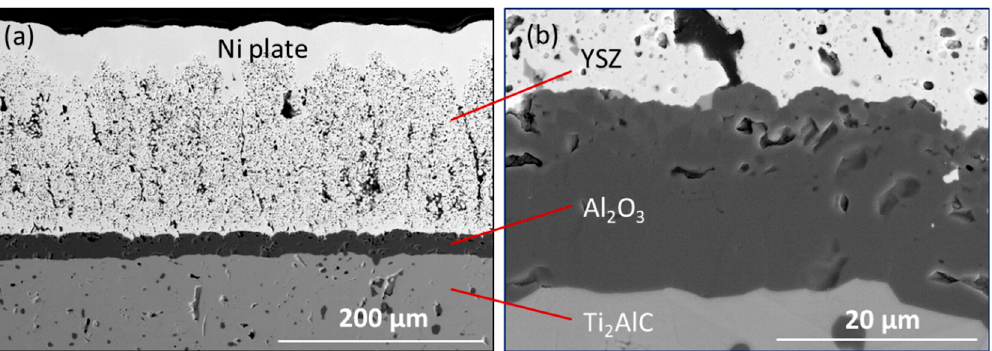
Figure 10. SEM/BSE hot zone cross-section of YSZ coated Ti 2 AlC after BRT (Mach 0.3, 500 h/1300 °C). ( a ) Full structure, ( b ) detail showing intact YSZ–Al 2 O 3 –Ti 2 AlC interfaces